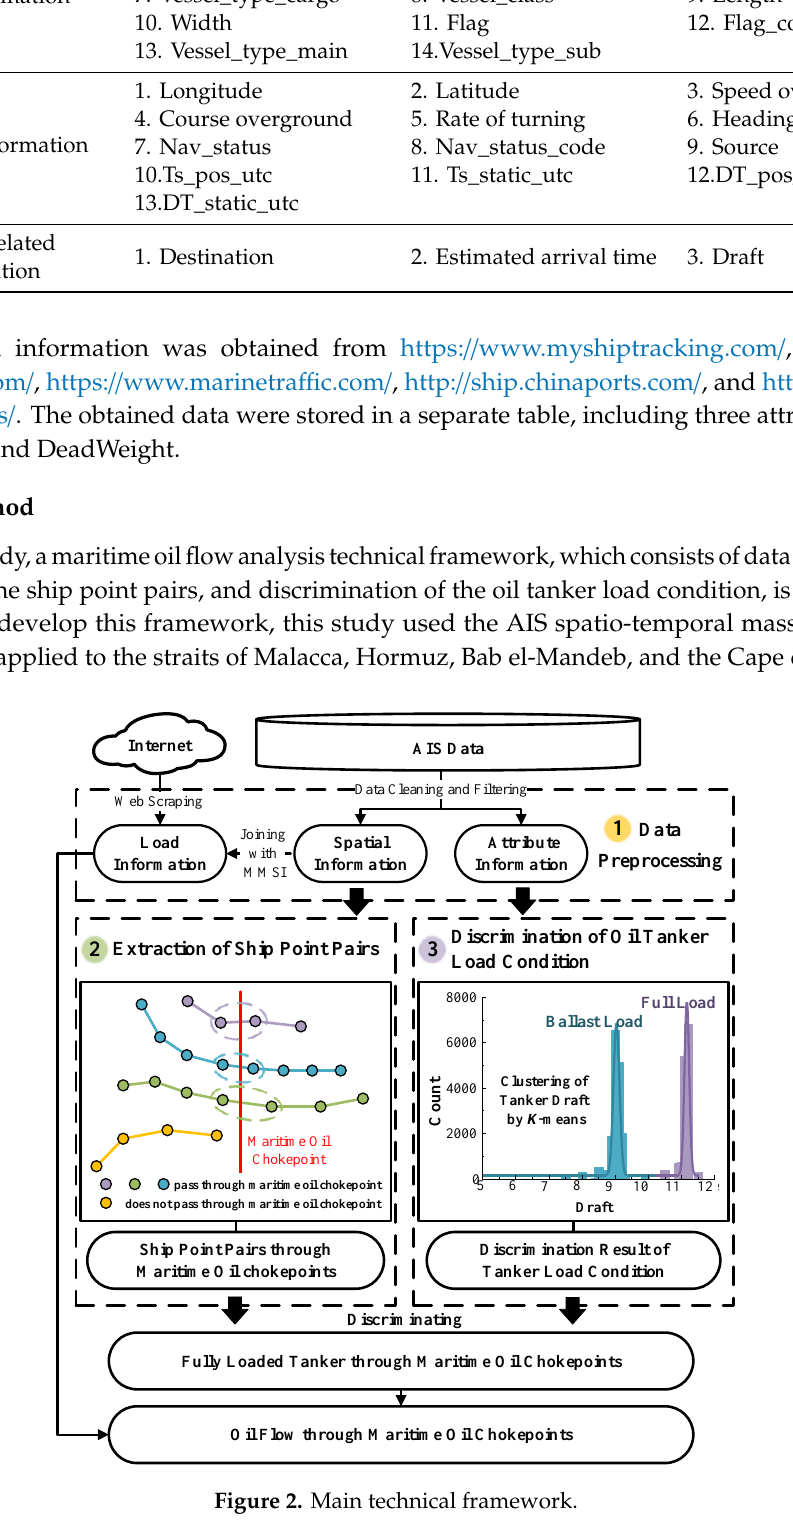
Table 2. Data cleaning standards. Data Type